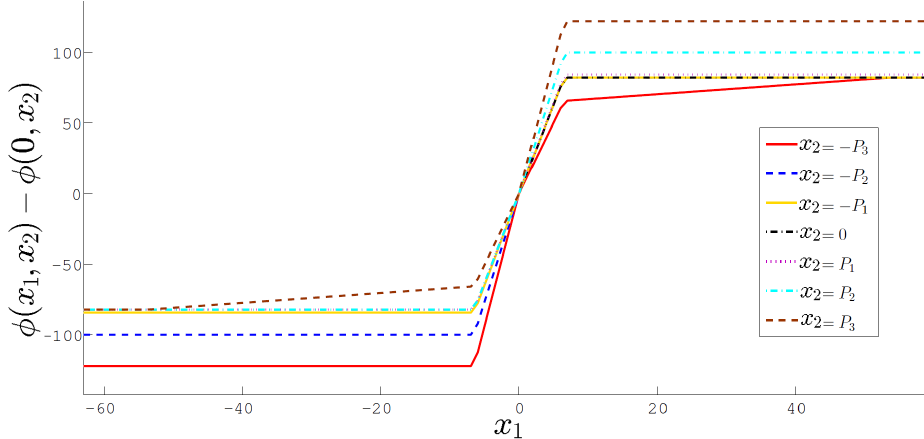
Figure 6. φ ( x 1 , x 2 ) – φ ( 0, x 2 ) with x 2 evaluated at every partition value P k .